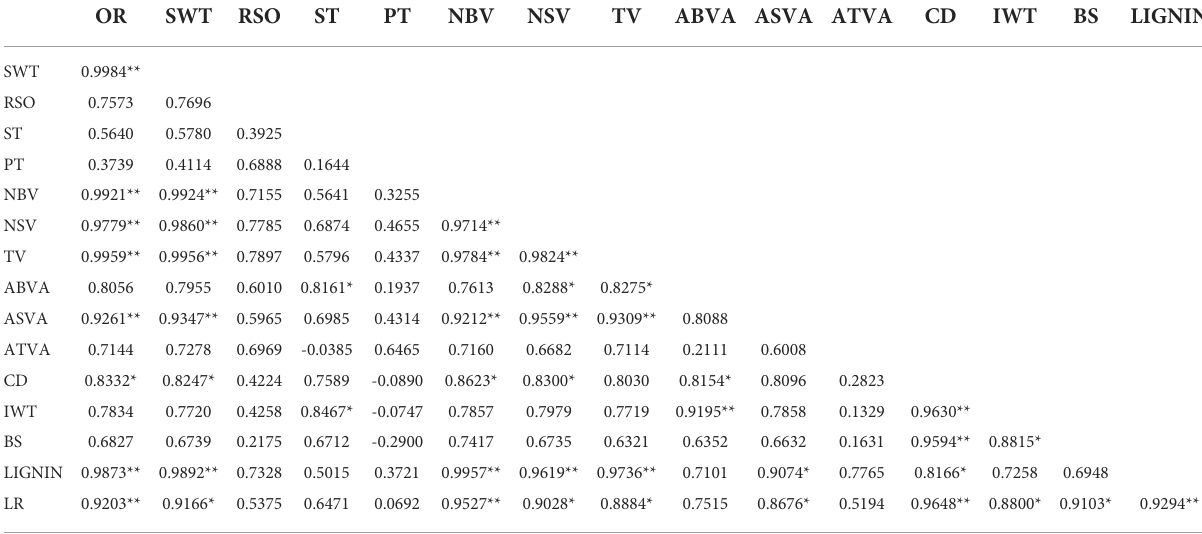
OR,outerradius;SWT,Stemwallthickness;RSO,Theratioofthethicknessofstemwalltoouterradius;ST,Proportionofsclerenchymatissue(%);PT,Proportionofparenchymaarea(%);